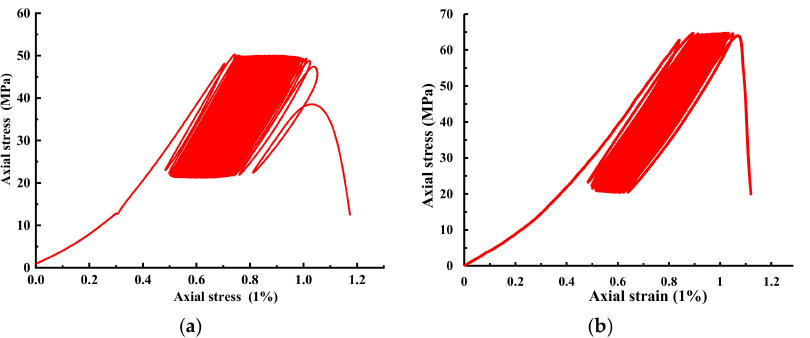
Figure 11. Fatigue stress–strain curves of sandstone at different lower limit stresses. ( a ) Sample F2-1; ( b ) Sample